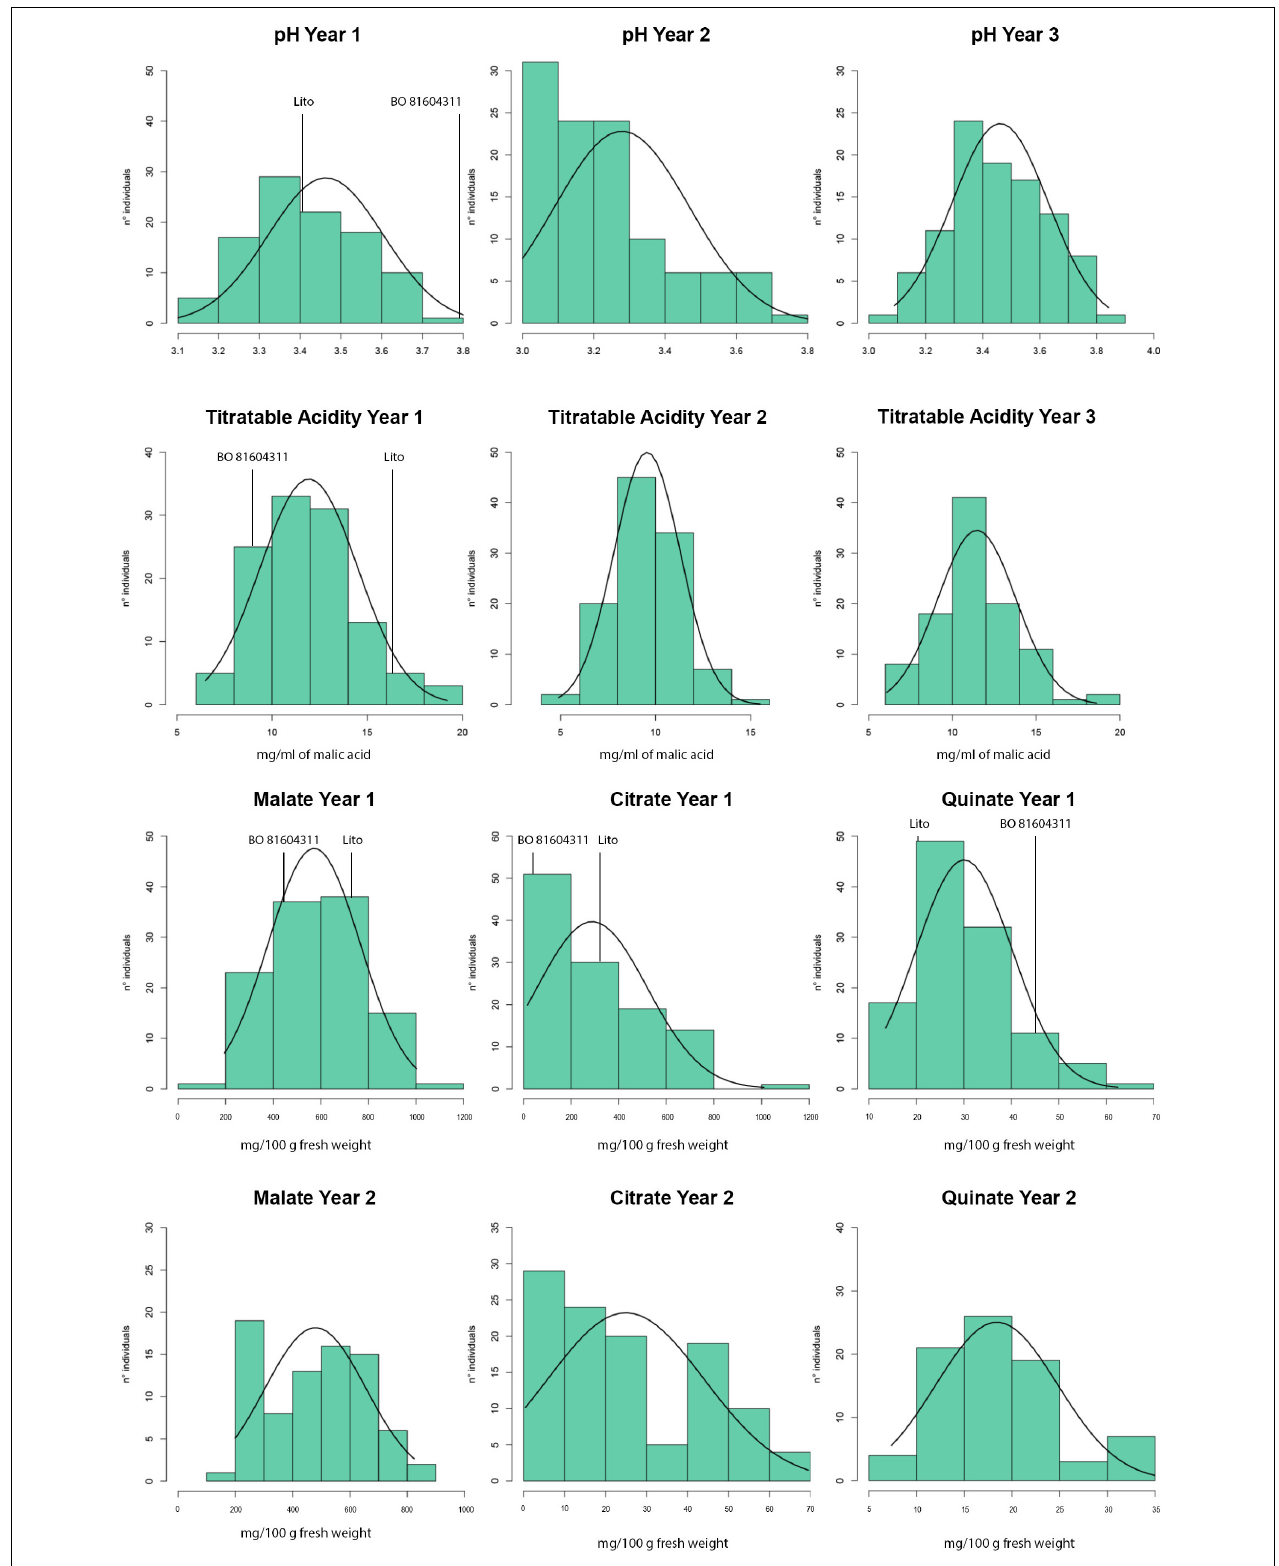
FIGURE 1 | Distributions of the phenotypic traits among the progeny of ‘Lito’ × ‘BO81604311’ in the different years of analysis.